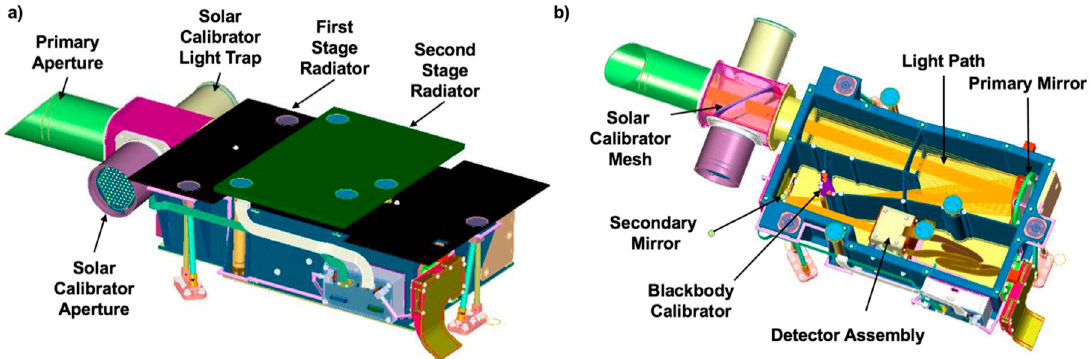
Figure 1. ( a ) Mechanical drawing of the Origins, Spectral Interpretation, Resource Identification, Security–Regolith Explorer (OSIRIS-REx) Visible and Infrared Spectrometer (OVIRS) instrument with external features labeled. ( b ) Internal optical elements and light path (orange) (both reproduced from Reuter et al. (2018)). Light enters either the primary aperture (green) or the solar calibrator aperture (purple), which scatters multiple light beams off a nickel mesh and into the main light path. Not visible are the internal filament sources, which are adjacent to the secondary mirror.